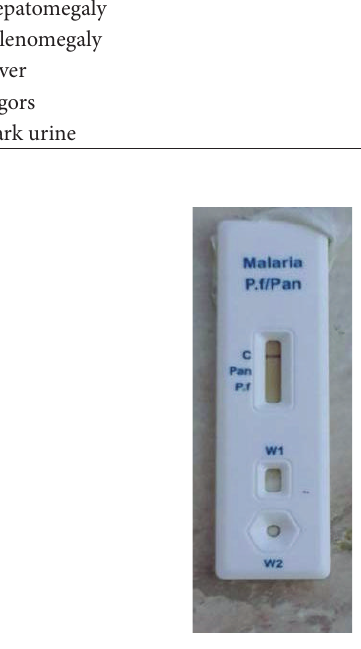
Figure 2: Negative RDT for Plasmodium falciparum and Plasmod- ium species.